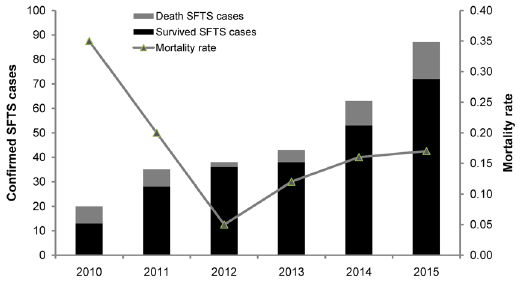
Figure 2. The mortality of SFTS cases in Jiangsu and Anhui province during 2010 and